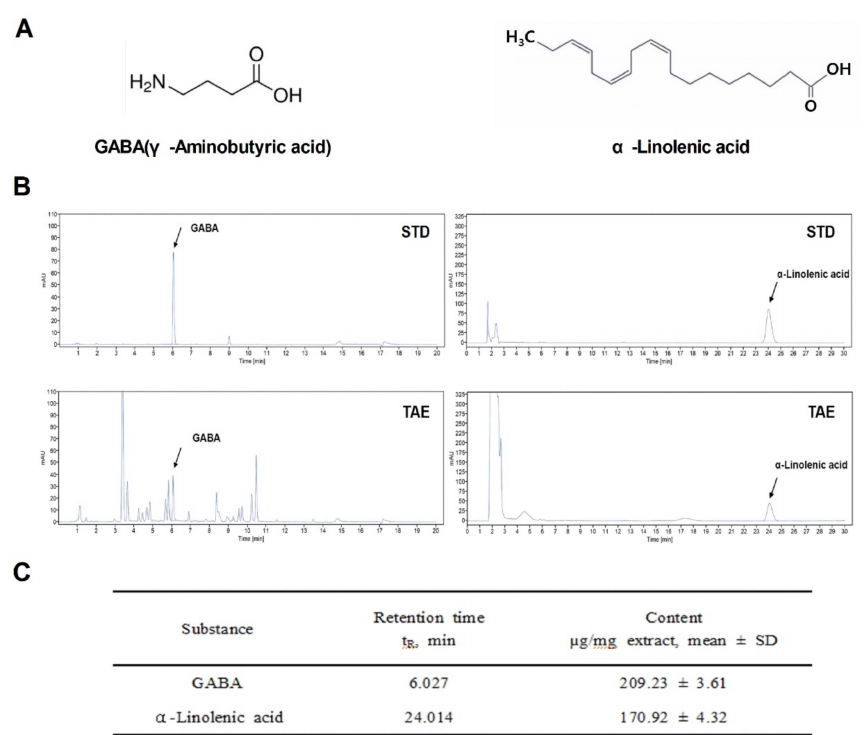
Figure 1. Chemical components of an ethanolic extract of Triticum aestivum sprouts. ( A ) Chemical structures of the two identified components (GABA and α -Linolenic acid). ( B ) Liquid chromatograms of standard compound mixtures (STD) and Triticum aestivum sprouts extract (TAE). ( C ) Quantification of isolated compounds from chromatograms (mean ± SD, n = 3). TAE, Triticum aestivum sprouts extract.